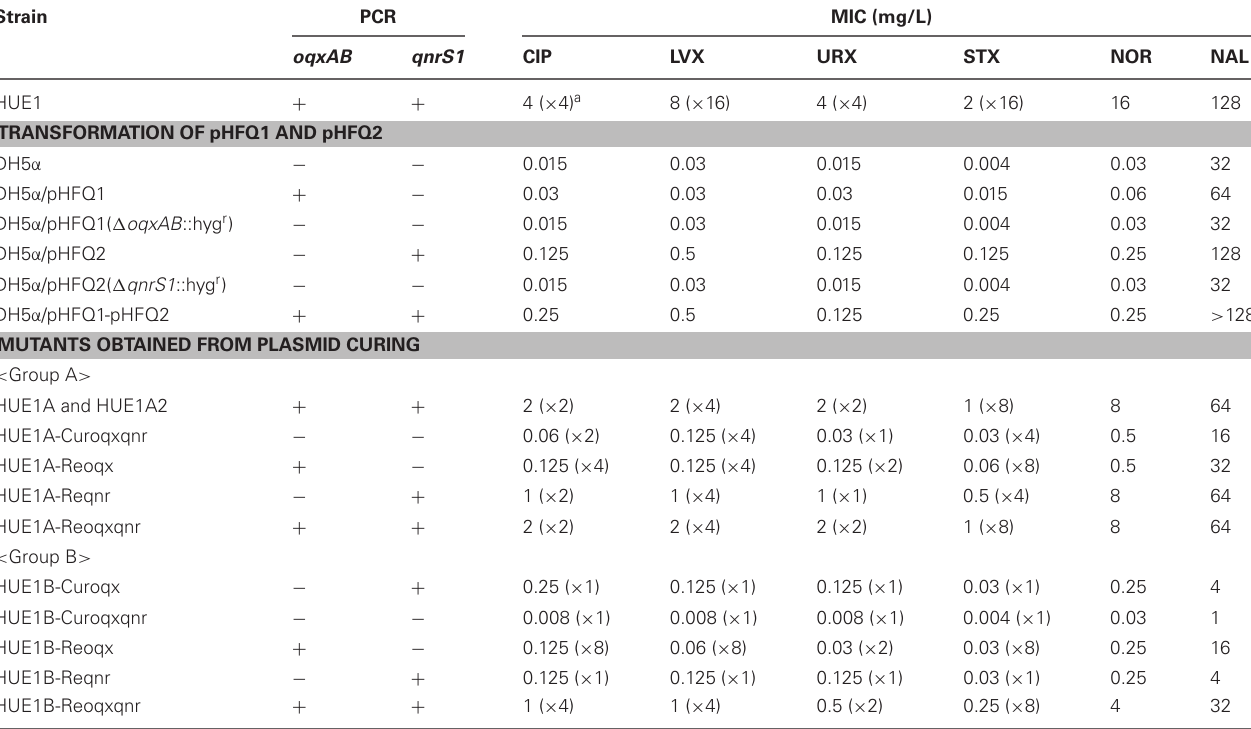
Table 3 | Fluoroquinolones and NAL susceptibilities of HUE1, transformants derived from DH5 α , and HUE1mutants derived from plasmid curing and reintroduction.